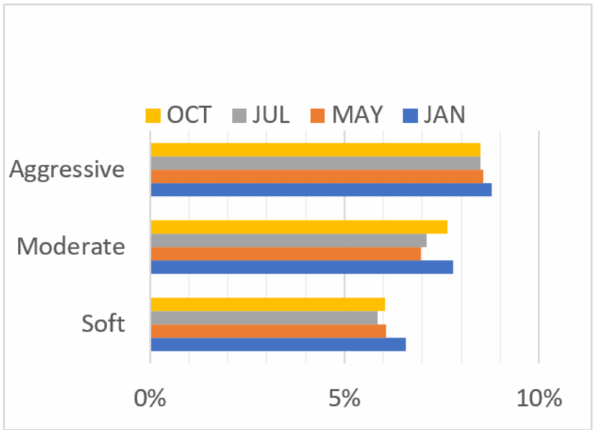
Figure 13. Total monthly energy